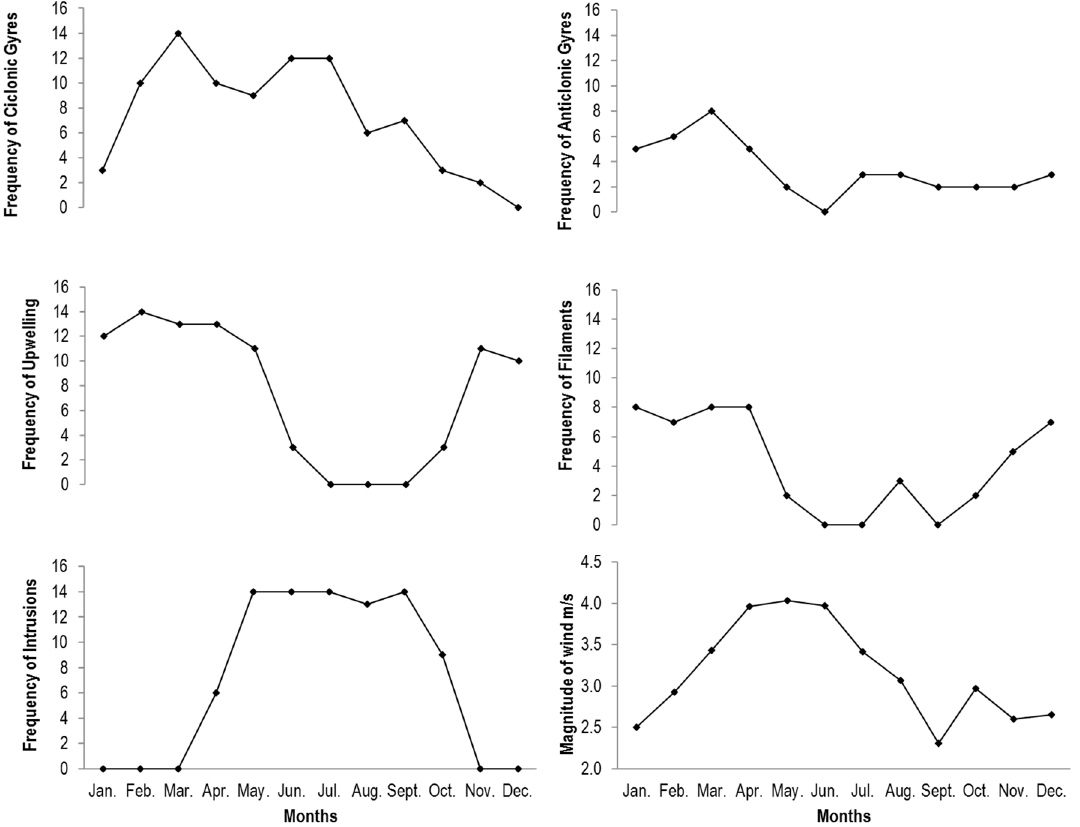
Figure 2. Cumulative monthly frequency observed of mesoscale phenomena and winds in the central and southern coastal region and adjacent deep zone in the Gulf of California.